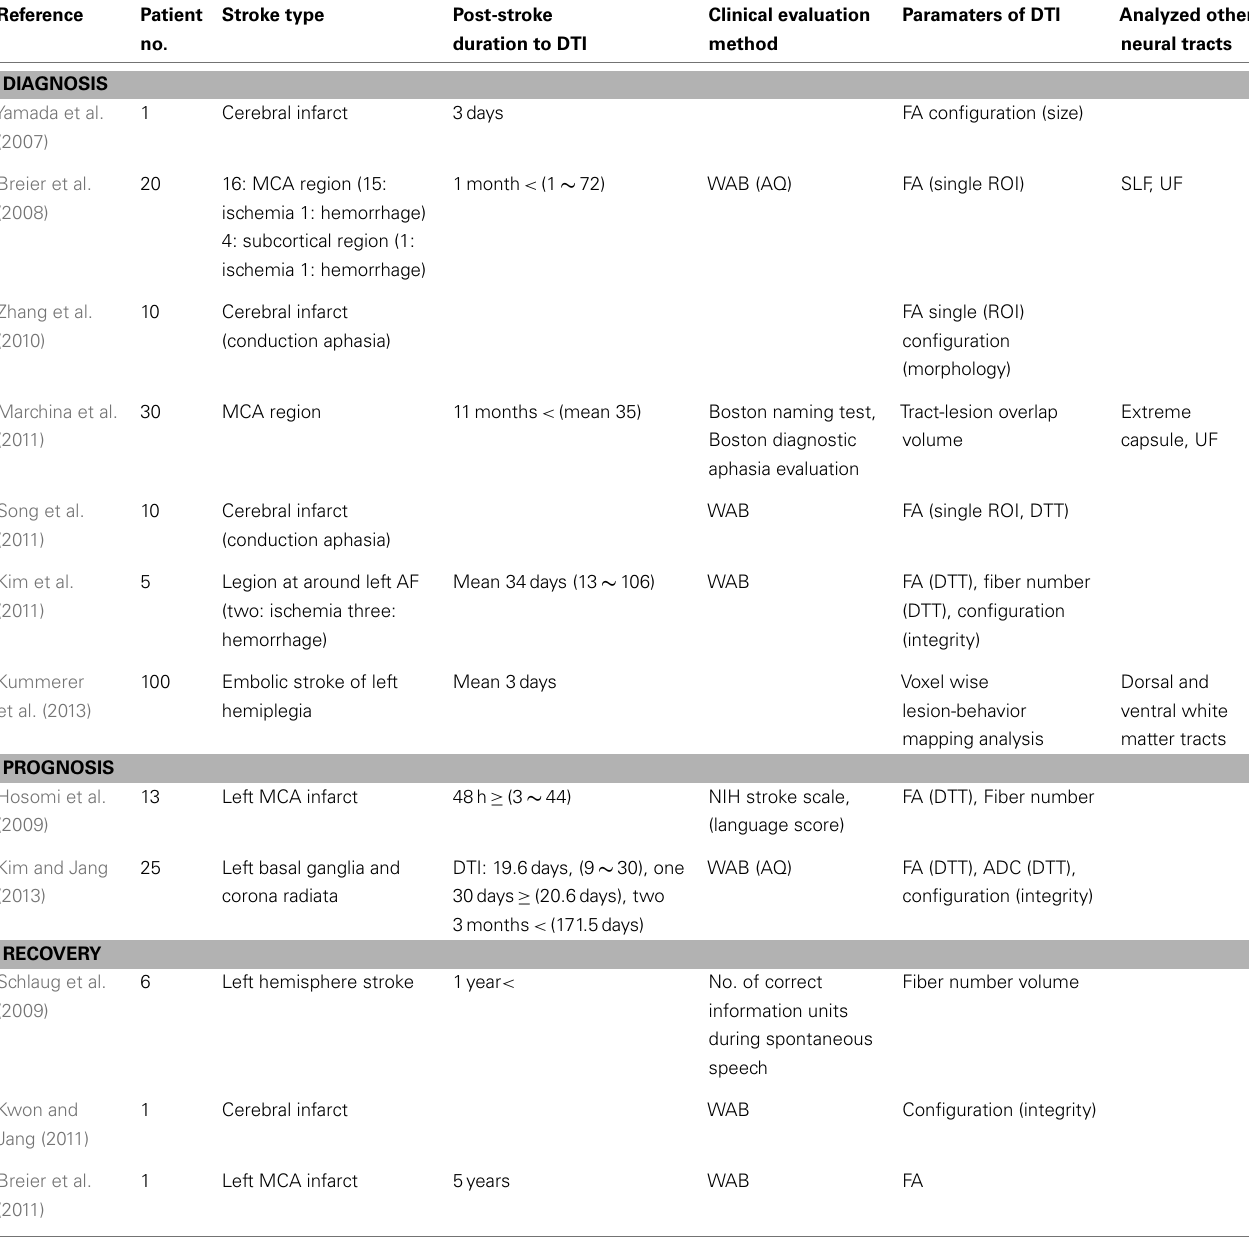
Table 1 | Previous diffusion tensor imaging studies on the arcuate fasciculus in stroke patients .